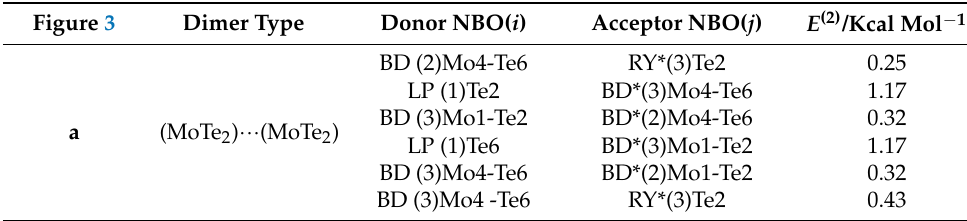
Table 3. RHF/Sapporo-TZP//MP2(Full)/def2-TZVPPD computed second-order hyper-conjugative charge transfer delocalization energies, E (2) , between the interacting monomers at the energy- minimized geometries of the (MoCh 2 ) 2 and (MoChCh (cid:48) 2 ) 2 (Ch (cid:48) = S, Se and Te)